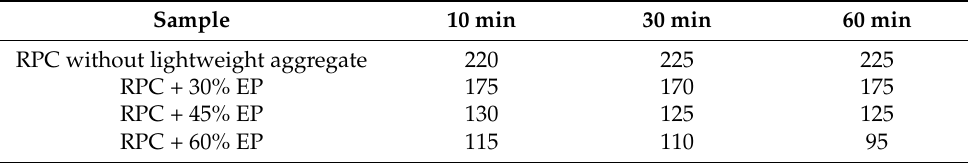
Table 4. Flow diameter of lightweight RPC mixes for 60 min (mm).